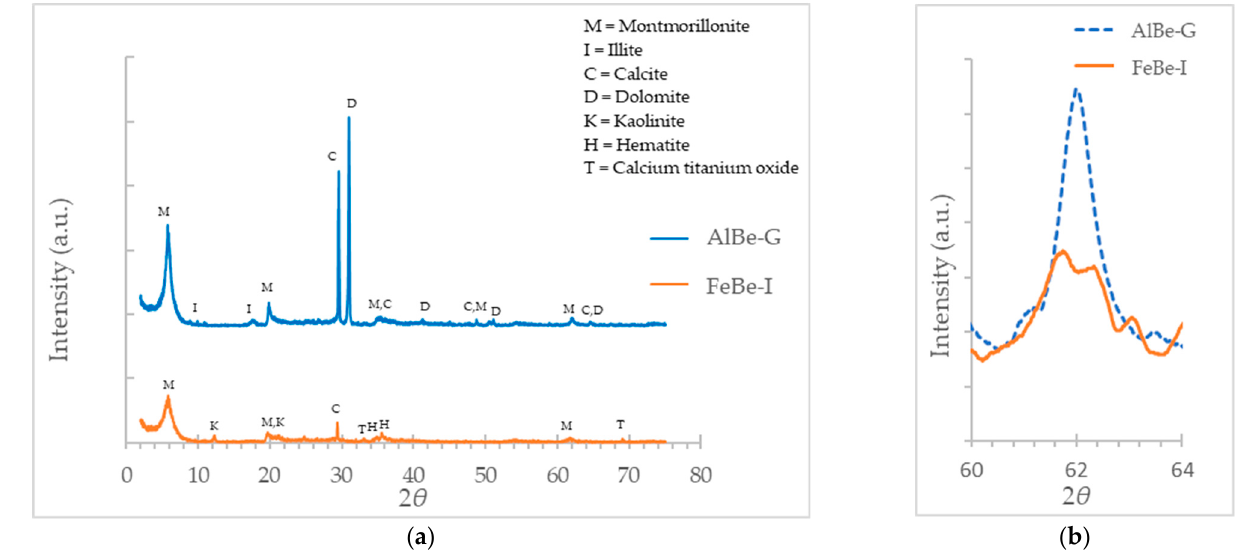
Figure 1. X-ray diffraction of raw materials ( a ) full diagram ( b ) 060